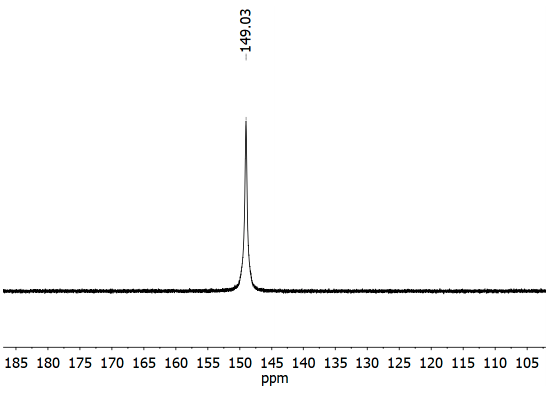
Figure 6. A part of 19 F NMR spectrum of Ba(OsF 6 ) 2 in anhydrous HF showing the OsF 6 − signal.